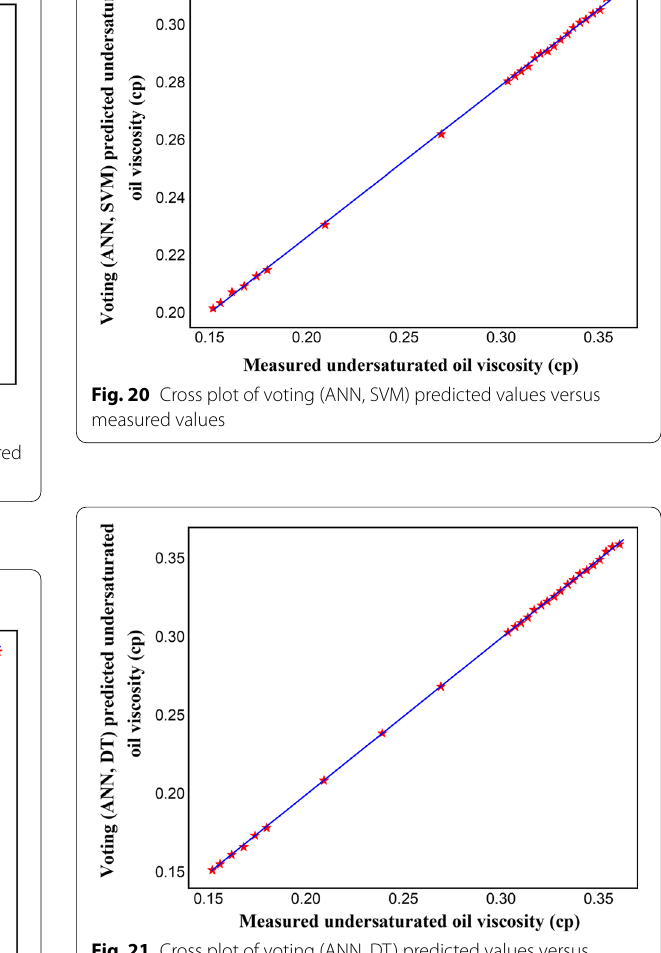
Fig. 21 Cross plot of voting (ANN, DT) predicted values versus measured